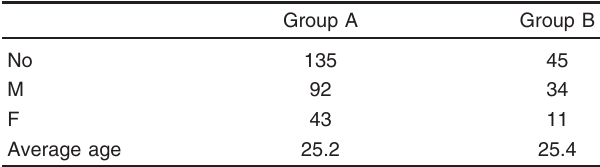
Table 2 The demographic data